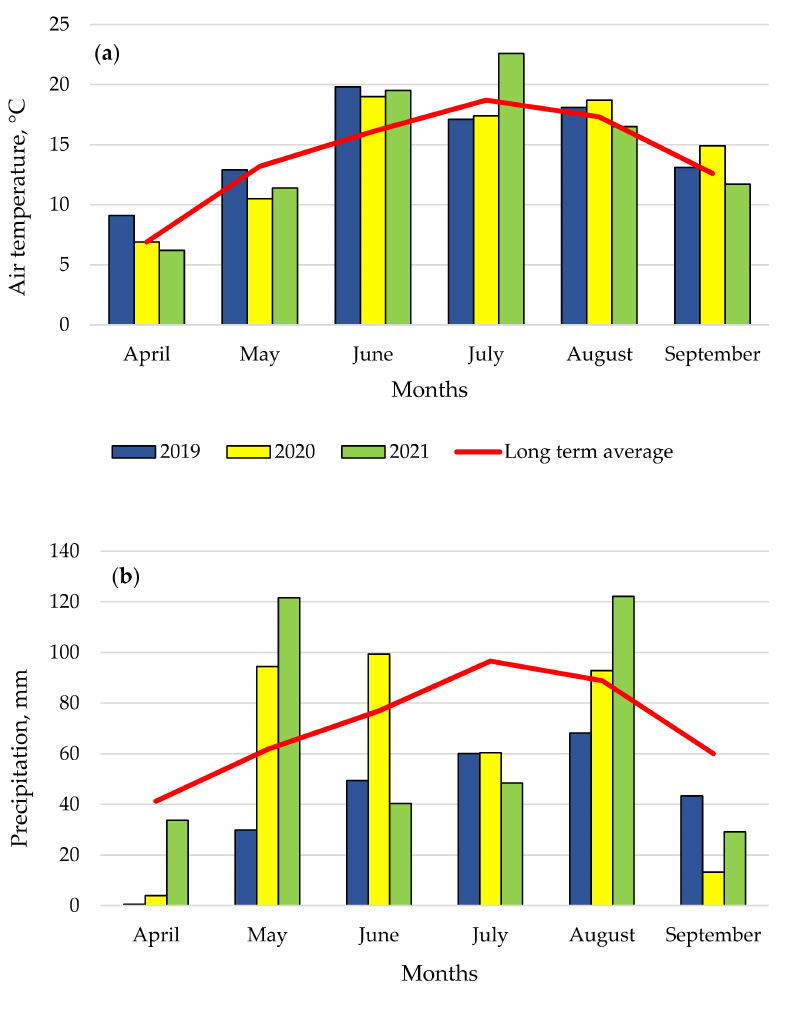
Figure 1. Meteorological conditions (air temperature ◦ C ( a ), precipitation in mm ( b )) in the year of the experiment (2019–2021), Kaunas Meteorological